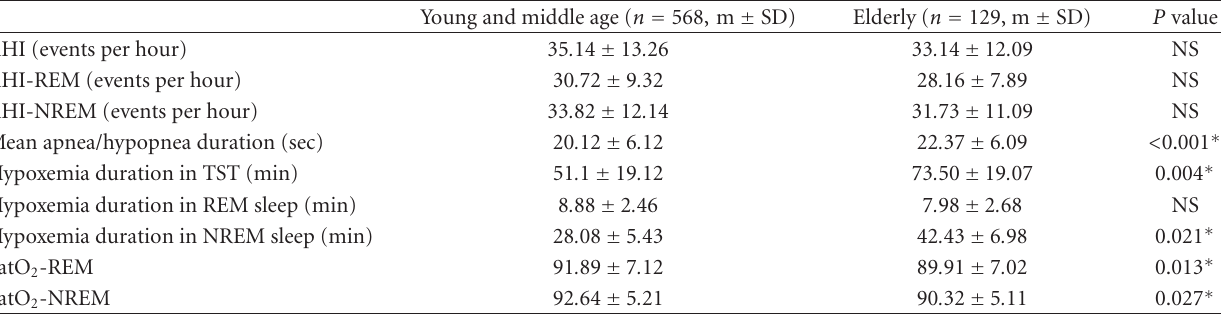
Table 2: Polysomnographic findings in Greek male patients with OSAS.